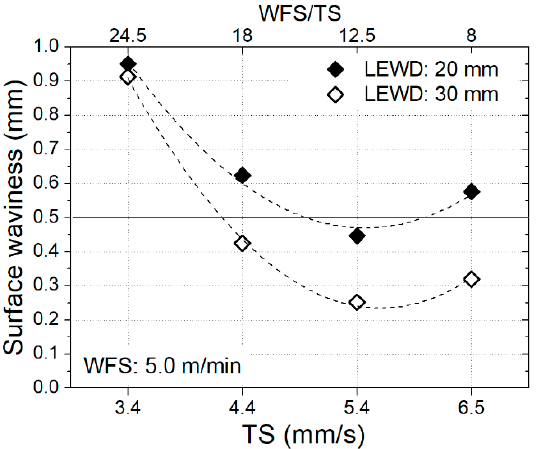
Figure 15. Comparison of surface waviness according to WFS and TS values for the LEWD parameter set at 20 and 30 mm (acceptance criteria: Below the red line).